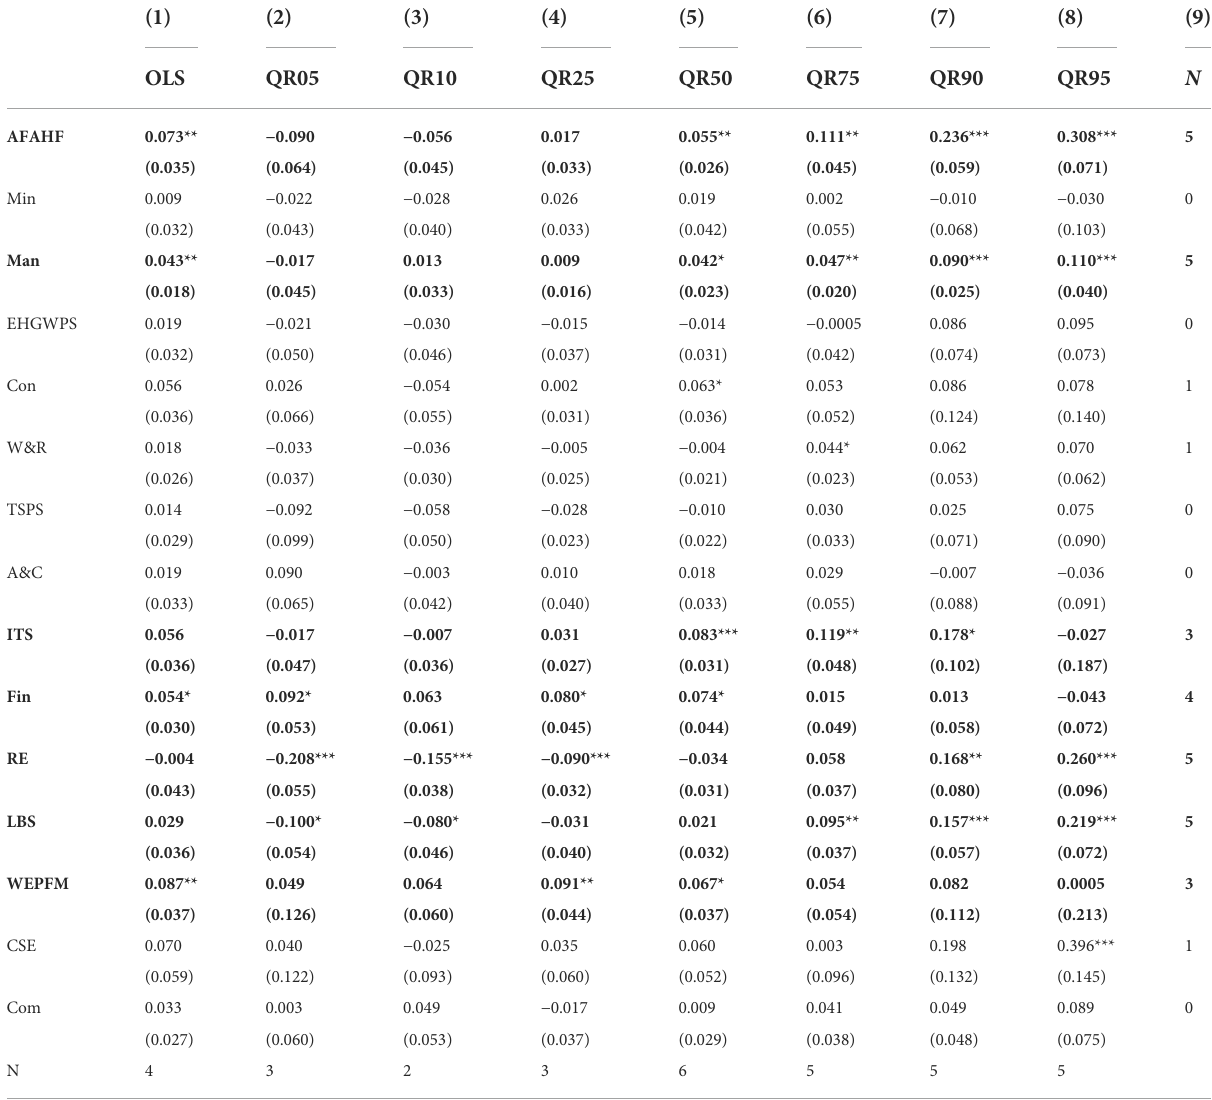
TABLE 3 Coef fi cients of Trend in OLS and quantile regressions by